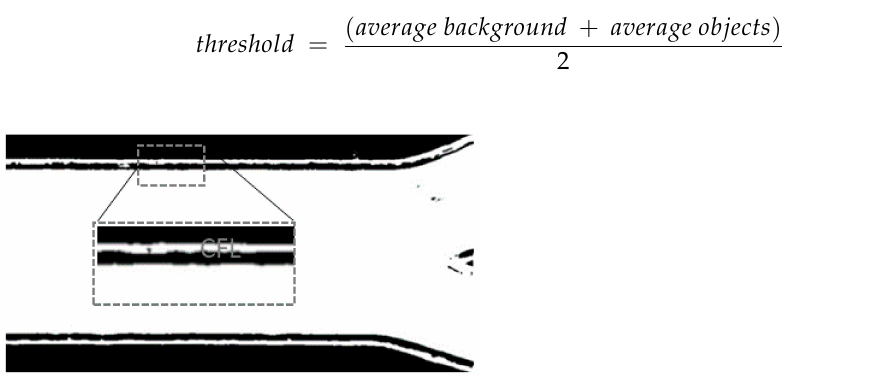
Figure 13. The obtained image from the ZProject method with the projection maximum intensity to extract the data. It shows a well defined CFL